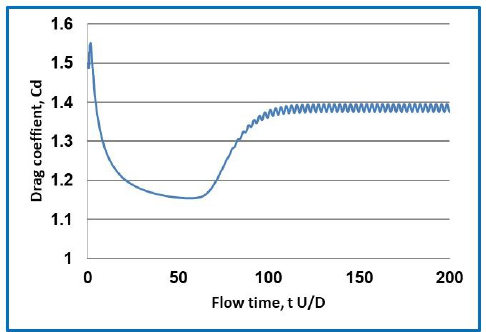
Figure 1: Schematic drawing of the computational domain Overset mesh method available in ANSYS FLUENT 19.0 der. Overset mesh technique combines two overlapping